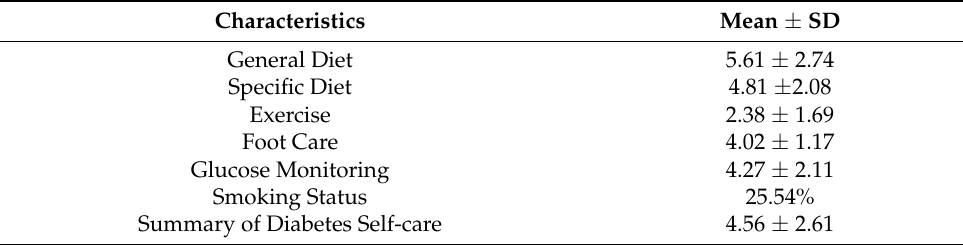
Table 2. The DM self-care activities of the T2D